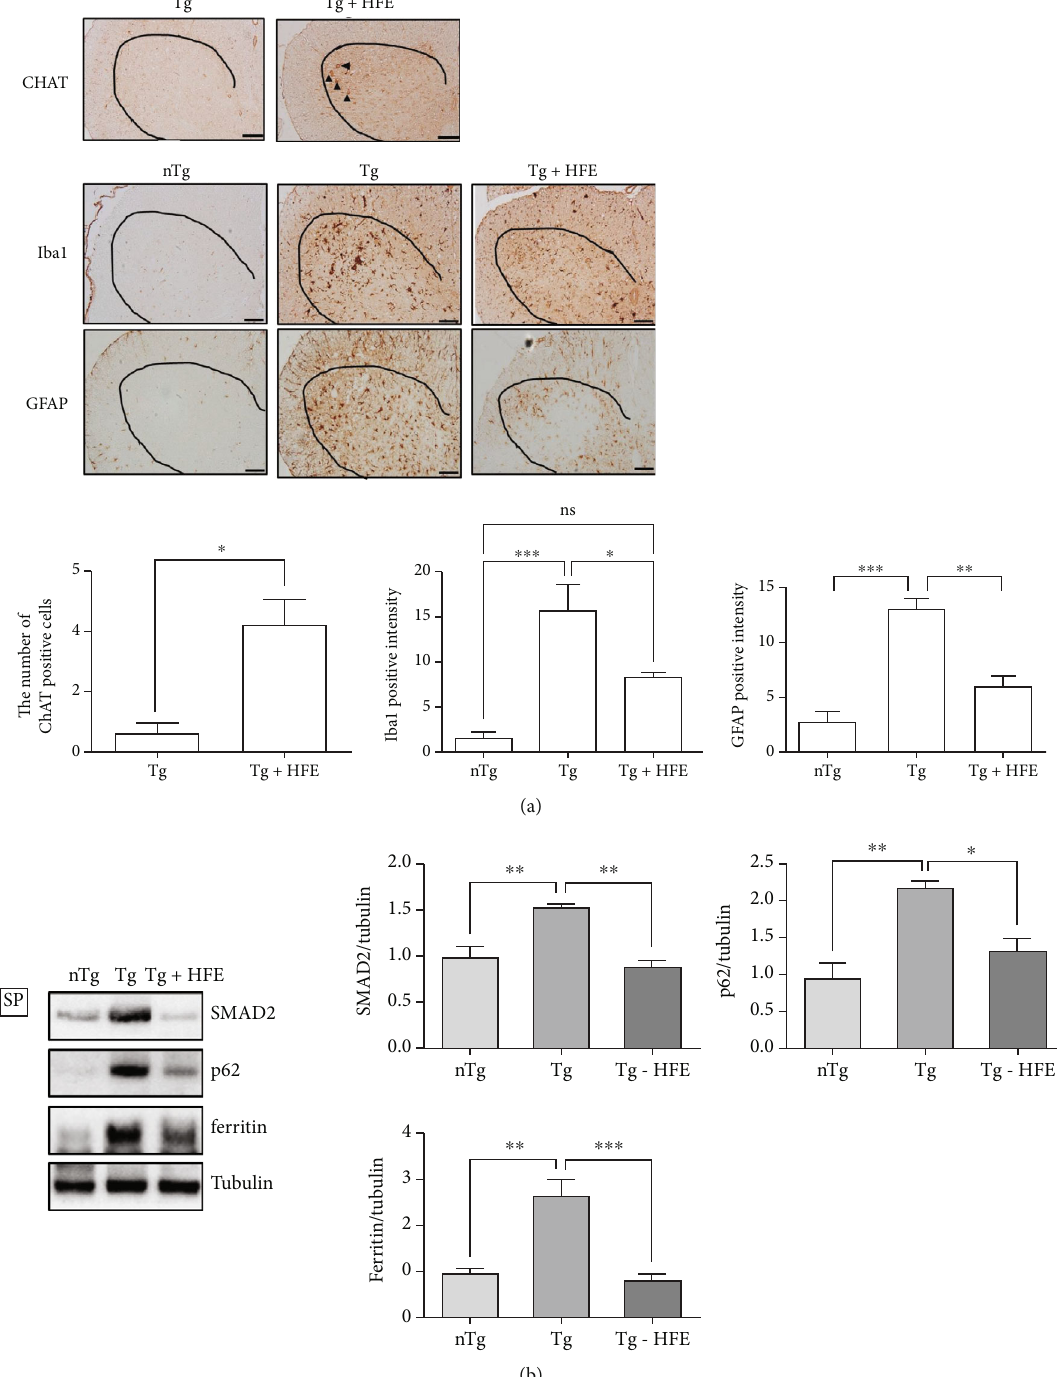
Figure 5: Herbal formula extract (HFE) reduced neuroin fl ammation in the spinal cord of hSOD1 G93A mice. (a) Representative images of ventral horn of spinal cord showing diaminobenzidine staining using anti-CHAT, anti-Iba1, and anti-GFAP. HFE administration increased CHAT-positive cells and reduced Iba1- and GFAP-positive cells in the ventral horn of the spinal cord in the Tg group. Quanti fi cation of positive intensity of primary antibody. n =3 – 4 mice per group. Scale bars: 2mm. (b) Representative image of SMAD2, p62, and ferritin expression detected using western blotting analysis in the nTg, Tg, and Tg-HFE groups. Tubulin was used as the loading control. Quanti fi cation of immunoblots of GFAP, SMAD2, P62, and ferritin. Data are presented as the mean ± SEM. n =3 – 4 mice per group. ∗ p < 0 : 05 , ∗∗ p < 0 : 01 , ∗∗∗ p < 0 : 001 . nTg: nontransgenic mice, Tg: transgenic mice, Tg+ HFE: HFE-treated transgenic